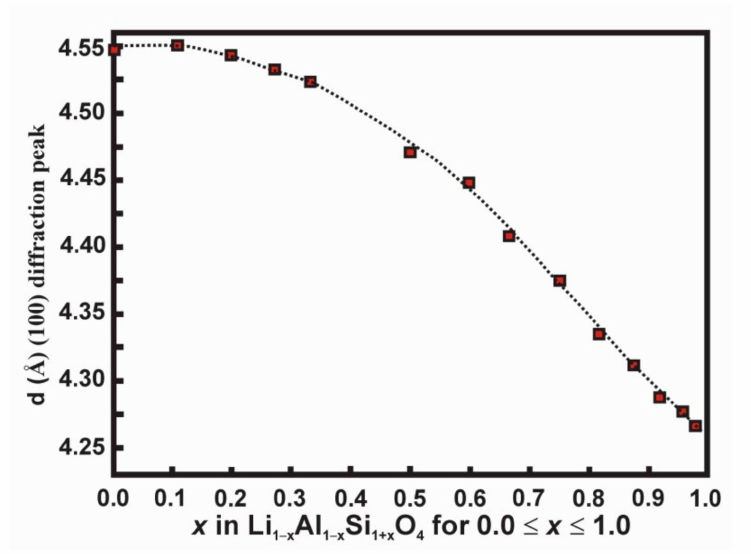
Figure 3. Variation of the spacing d in Å for the (200) diffraction peak of the β -eucryptite solid solution series or of the (100) diffraction in α -quartz, using Cu K α 1 radiation, for x values in Li 1 − x Al 1 − x Si 1+x O 4 along the solid-solution series, using samples crystallized at 1 atm and temperatures between 675 ◦ C and 1200 ◦ C (Table 2, Appendix